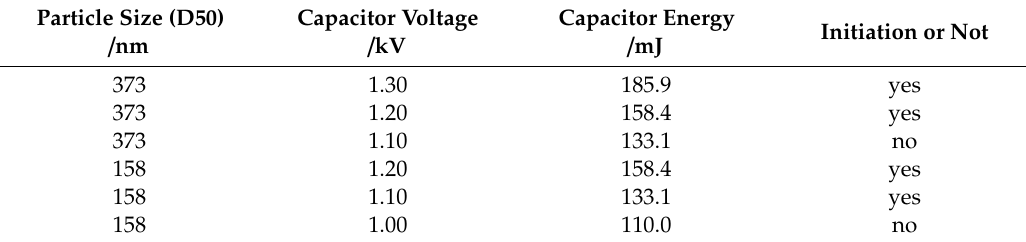
Figure 8. Firing device the CDU for initiating the HNS. Table 4. Initiation results of two kinds of HNS. Table 4. Initiation results of two kinds of HNS.